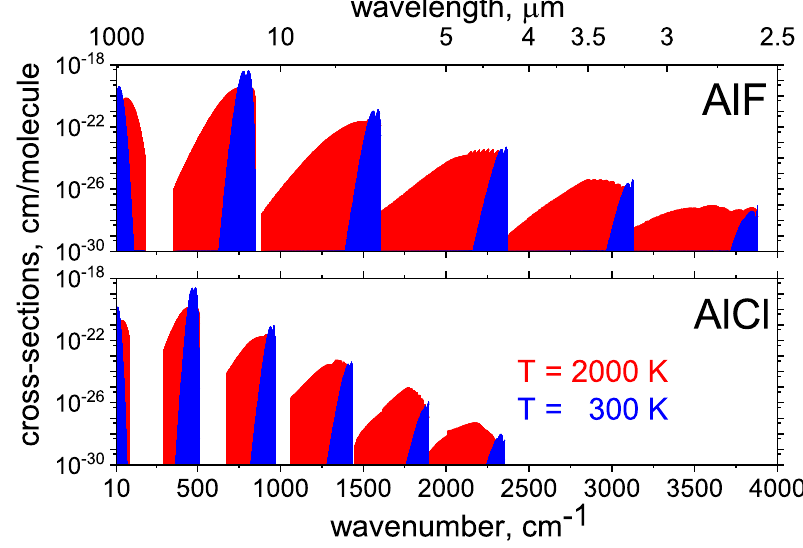
Figure 1. Cross sections of AlCl and AlF computed using the line list by Yousefi and Bernath [28] represented in the ExoMol